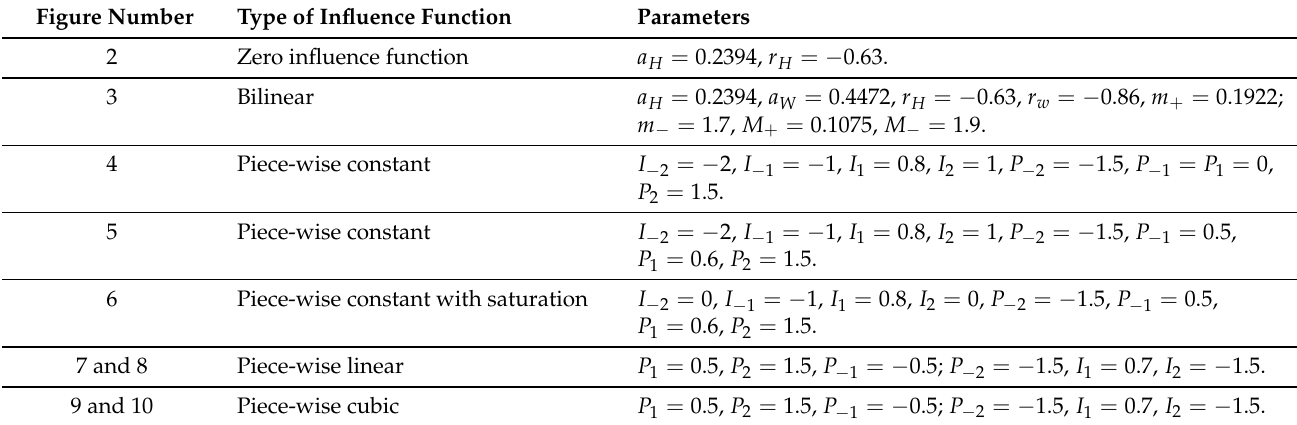
Table 1. Summary of parameter values used. The same values for a H , a W , r H , and r W are used in all our examples. Figure